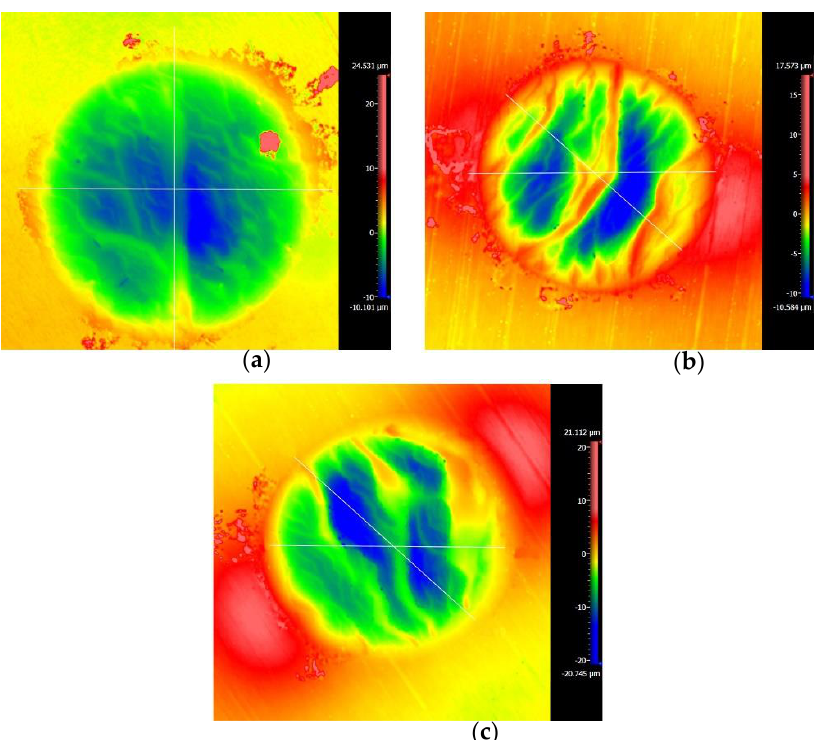
Figure 13. The profile of wear scars of PVDF thin films with ƒ = 15 Hz, D = ±20 μm, and V c = 0 V: